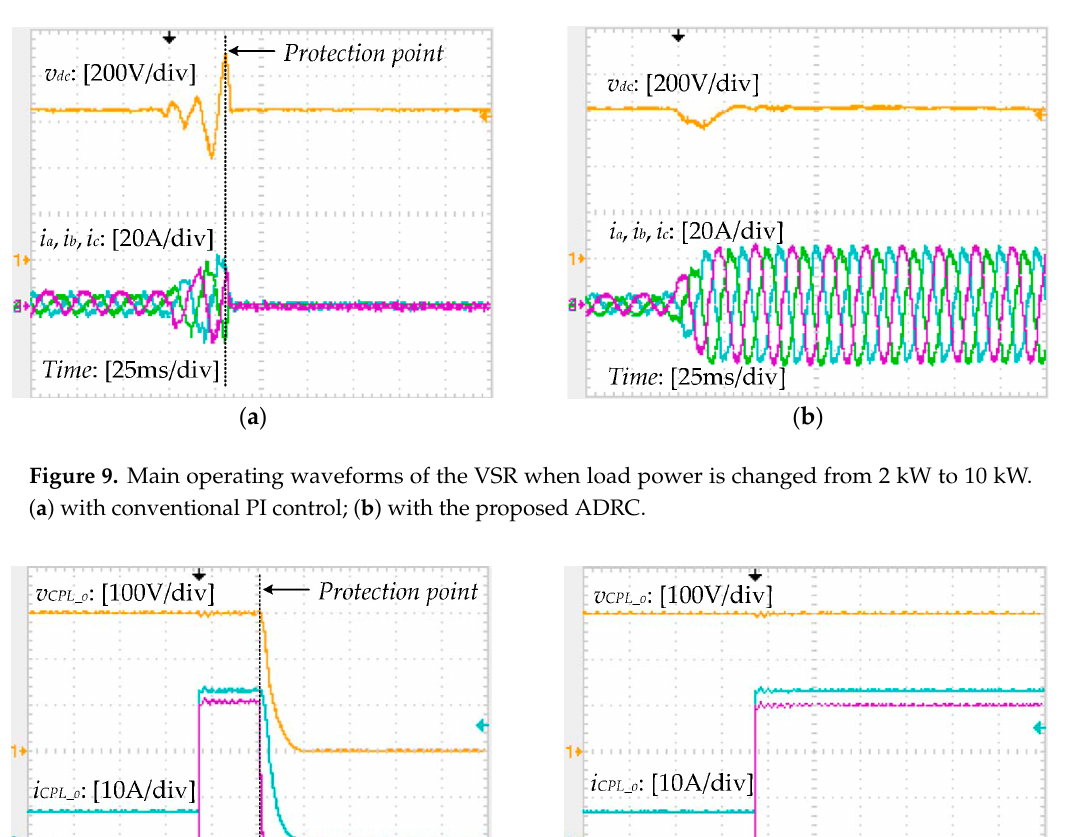
Figure 8. Prototype of the three-phase VSR with CPL.